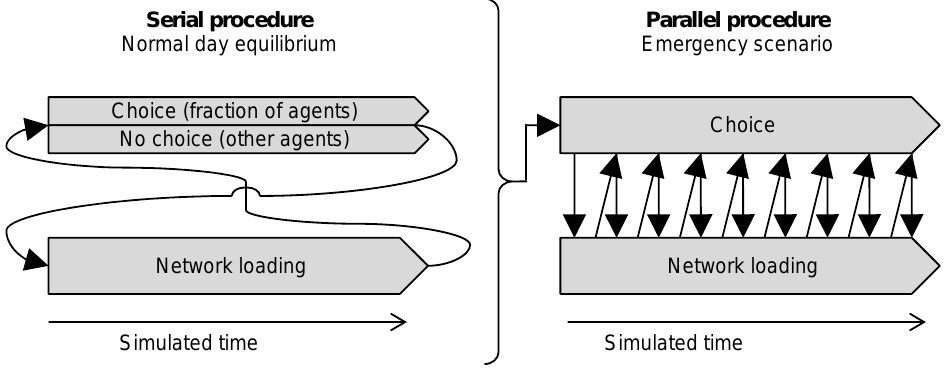
Figure 1. Flow charts of procedures for the overall model